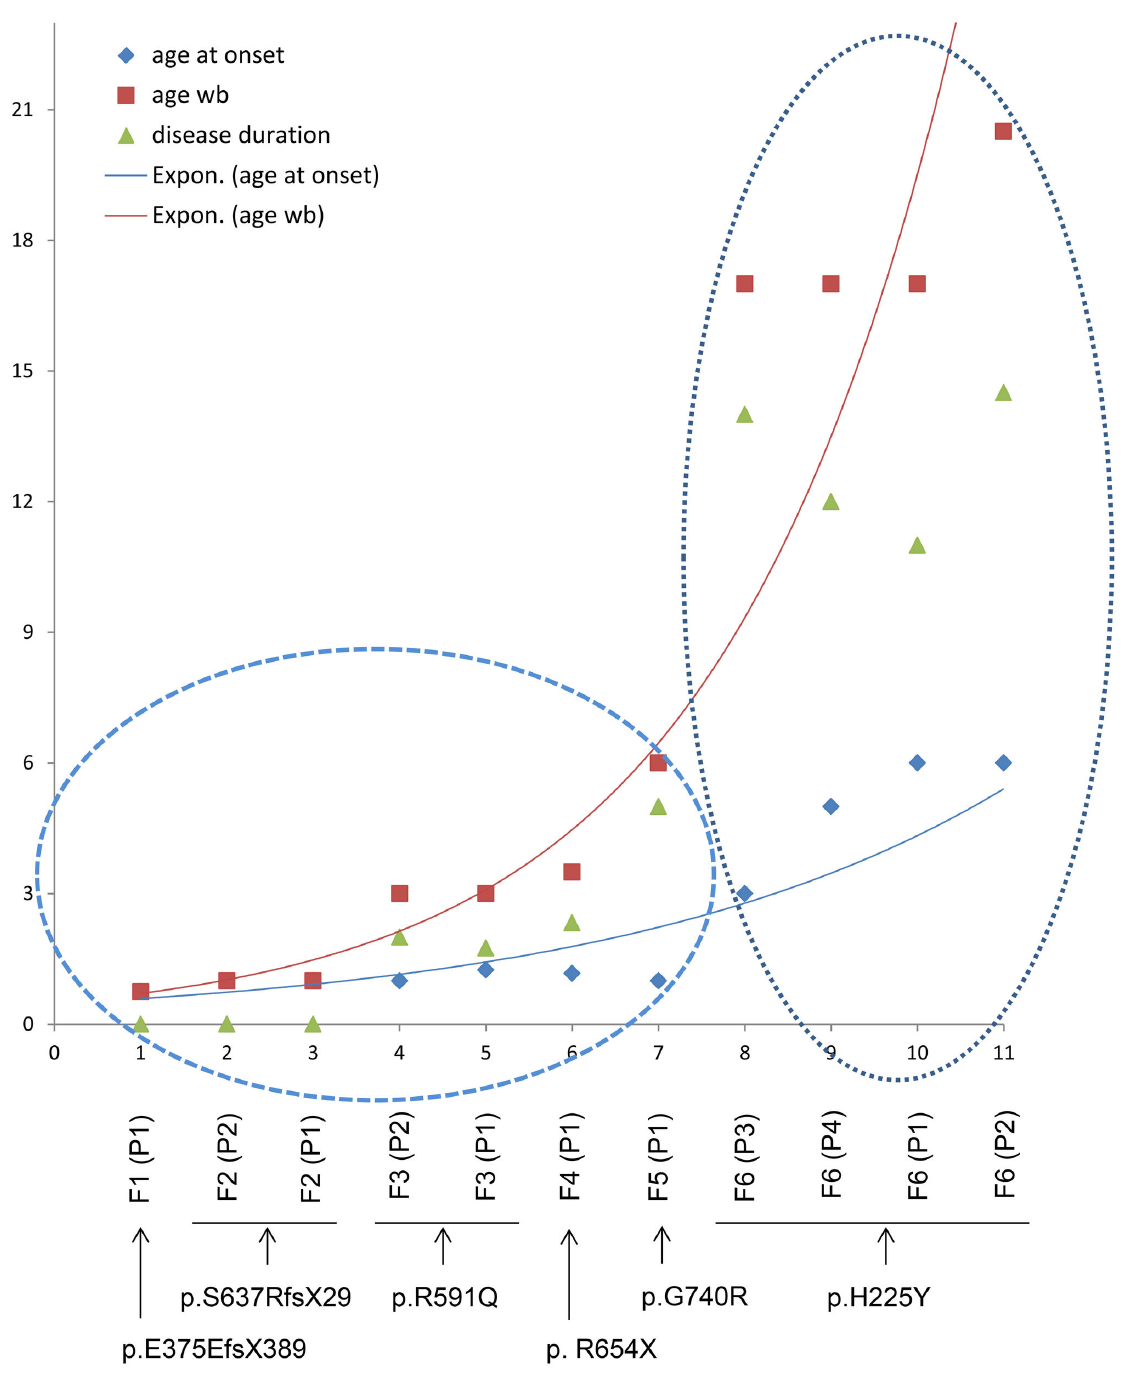
Figure 7. Genotype-phenotype correlation. Graphic representation of the evolution exponential tendency curves of the functional disability (red curve and red squares) and of the age at onset of ataxia (blue curve and blue squares) which both seem to depend on the nature of the mutation. Each number in X axis corresponds to one patient. Below this axis are indicated the codes of patients (from Families 1 to 6) and the corresponding mutation. Y axis corresponds to the age per years. Two groups are identified (dashed ellipses) depending on the age at onset of ataxia. The first one encompasses the patients with ataxia manifesting at or before 15 months of age, and the second one, patients with an onset between 3 and 6 years. The age when becoming wheelchair- bound (red squares) and the disease duration (green triangles) are most prominent clusters in the second group. Abbreviations: wb = wheelchair-bound. Expon = exponential. doi: 10.1371/journal.pone.0076831.g007 PLOS ONE |